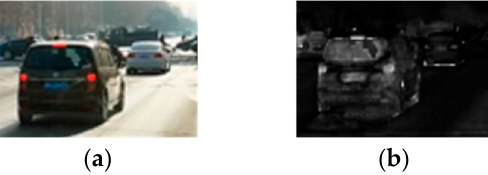
Figure 7. Image processing result. ( a ) Image of vehicle in RGB space; ( b ) Image of vehicle in HSV space. The image threshold segmentation is performed on the HSV color space image.